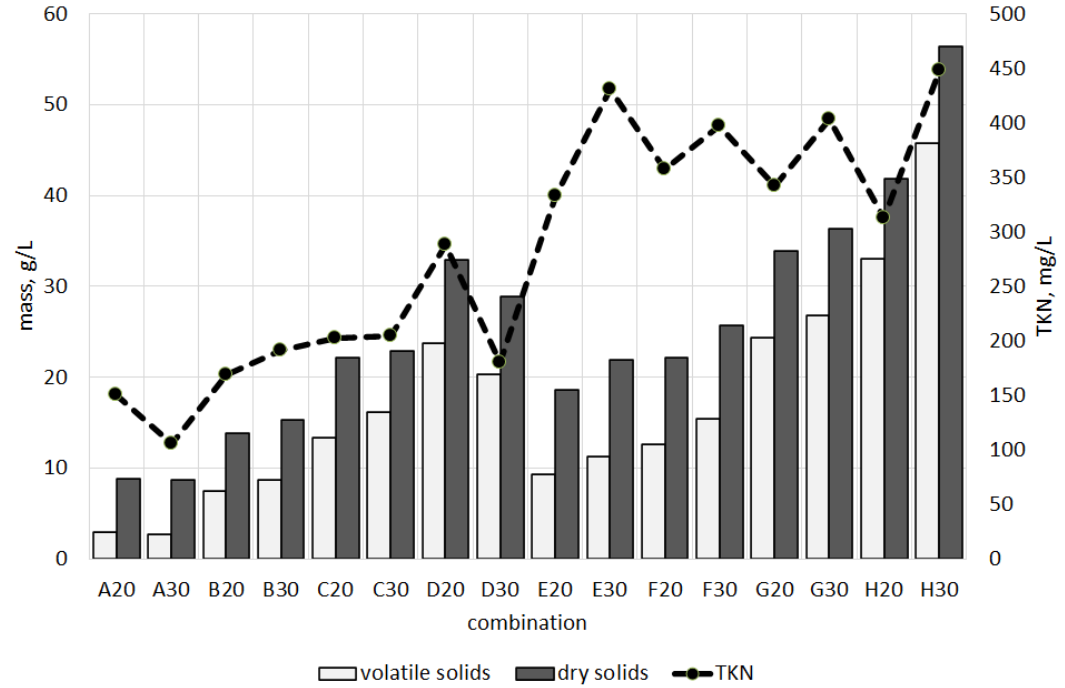
Figure 17. Mass balance during bioleaching for the tested combinations.